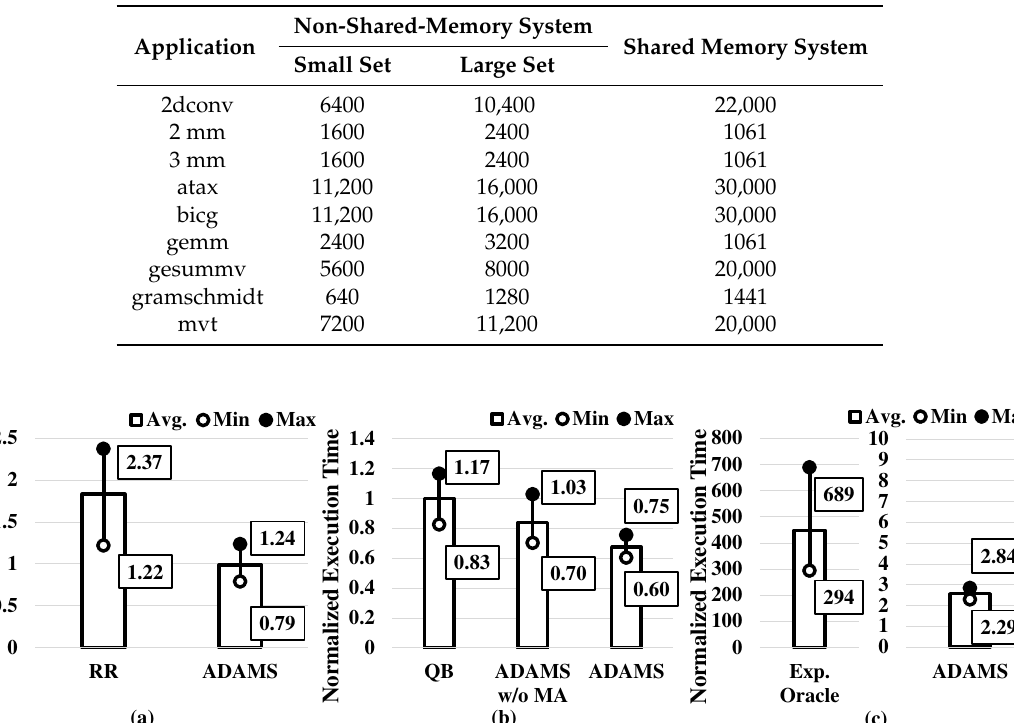
Table 4. Problem Sizes of Workloads.